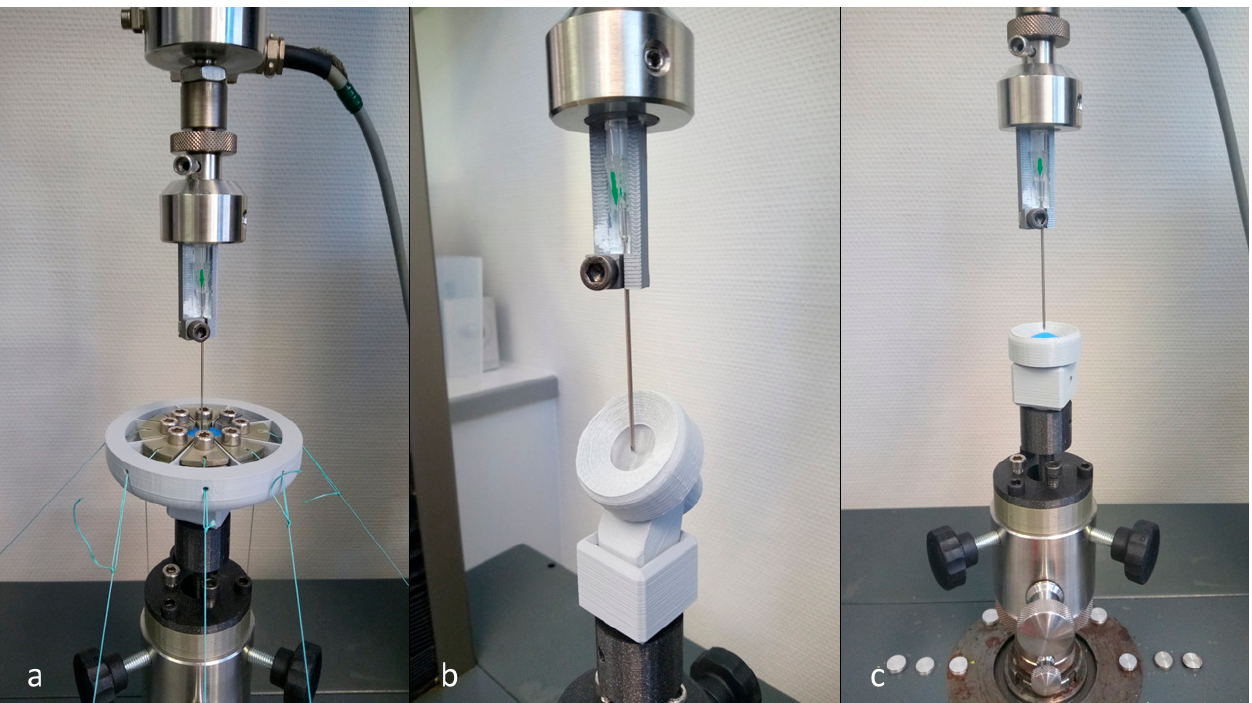
Figure 4. All three setups during the conduction of a test. The 90° prestressed setup testing a sample of Replisil 9N ( a ). The 45° non ‐ prestressed setup testing a sample of the Formlabs Elastic 50A ( b ). The 90° non ‐ prestressed control setup testing a sample of the Replisil 9N ( c ).